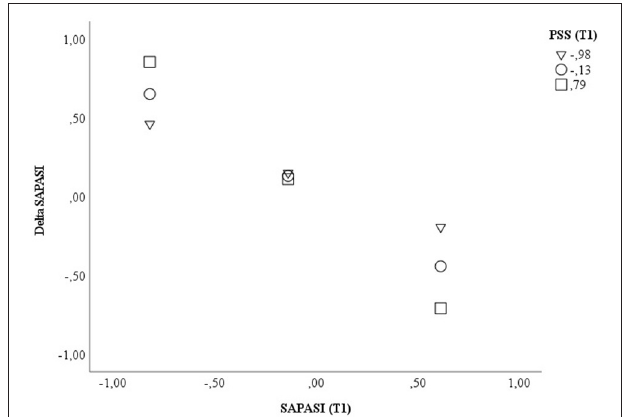
FIGURE 1 | Displayed are the data for visualizing the conditional effect of the predictor SAPASI at T1 on Delta SAPASI, depending on the severity of PSS perceived stress at T1. Z-standardized values were used. PSS, Perceived Stress Scale; SAPASI, Self-administered Psoriasis Area and Severity Index.